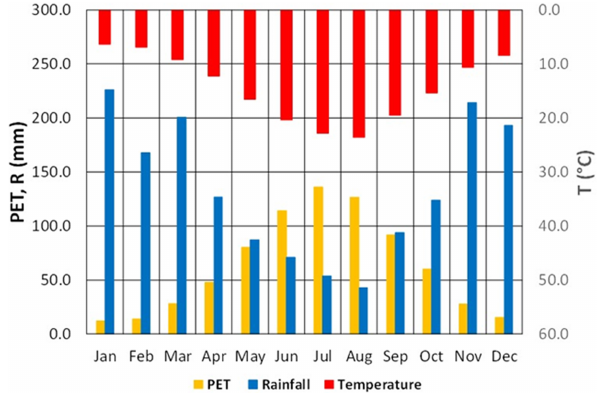
Figure 4. Mean monthly values of rainfall depth, R , temperature, T , and potential evapotranspiration, PET. R is calculated with the 2001–2017 data from the rain gauge installed in Cervinara by the meteorological alert network managed by the “Functional Centre for forecast, prevention and monitoring of risks and alerting for civil protection” of Campania Civil Protection Agency. T is calculated with the data monitored from 1979 to 1998 by the meteorologi- cal station of Montesarchio, managed by the National Hydrological Service. PET is estimated with the Thornthwaite expression (1948).